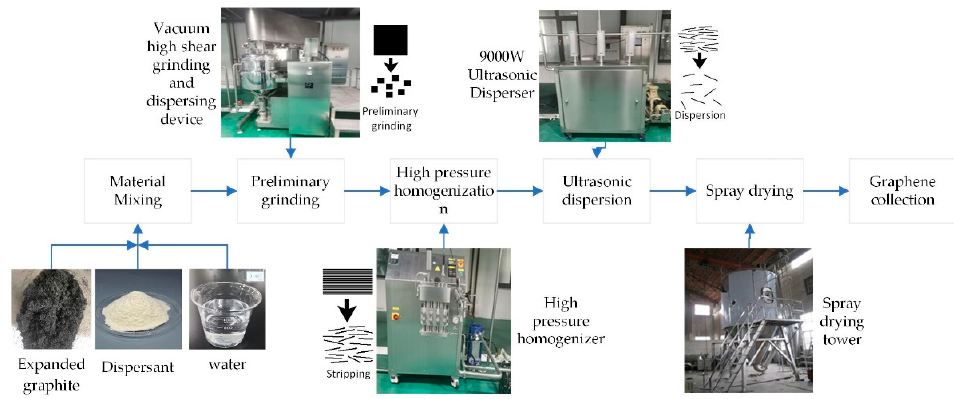
Figure 1. Preparation process of mechanically exfoliated graphene.